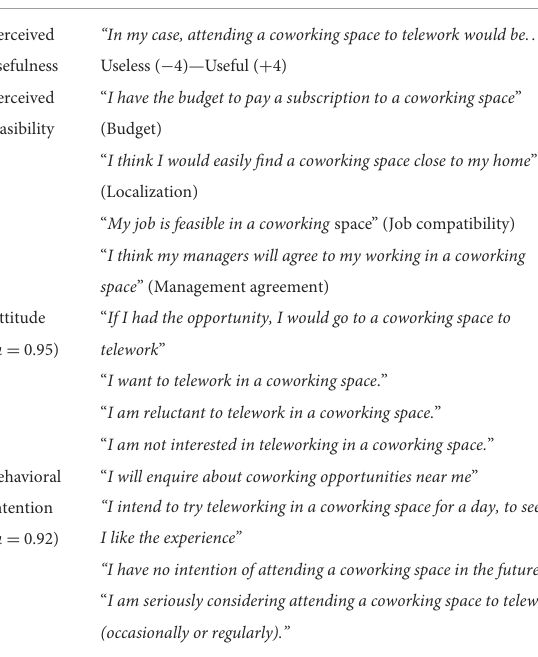
TABLE 3 Items used to measure: (1) Perceived usefulness, (2) Perceived feasibility, (3) Attitude, and (4) Behavioral intention. Dimension Items